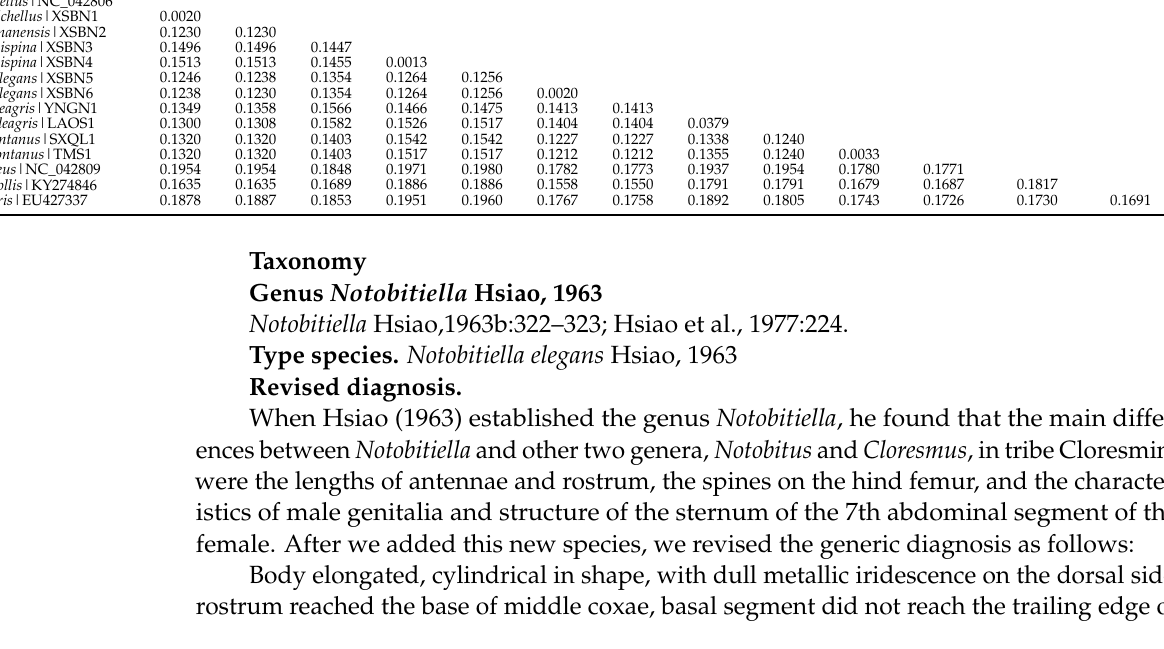
Figure 3. Neighbor-joining tree for six species of the tribe Cloresmini based on K2P distance in DNA barcodes. Numbers on branches represent bootstrap support based on 1000 replicates; scale equals K2P genetic distance. Table 2. Kimura 2-parameter (K2P) pairwise genetic distances based on complete COI gene.